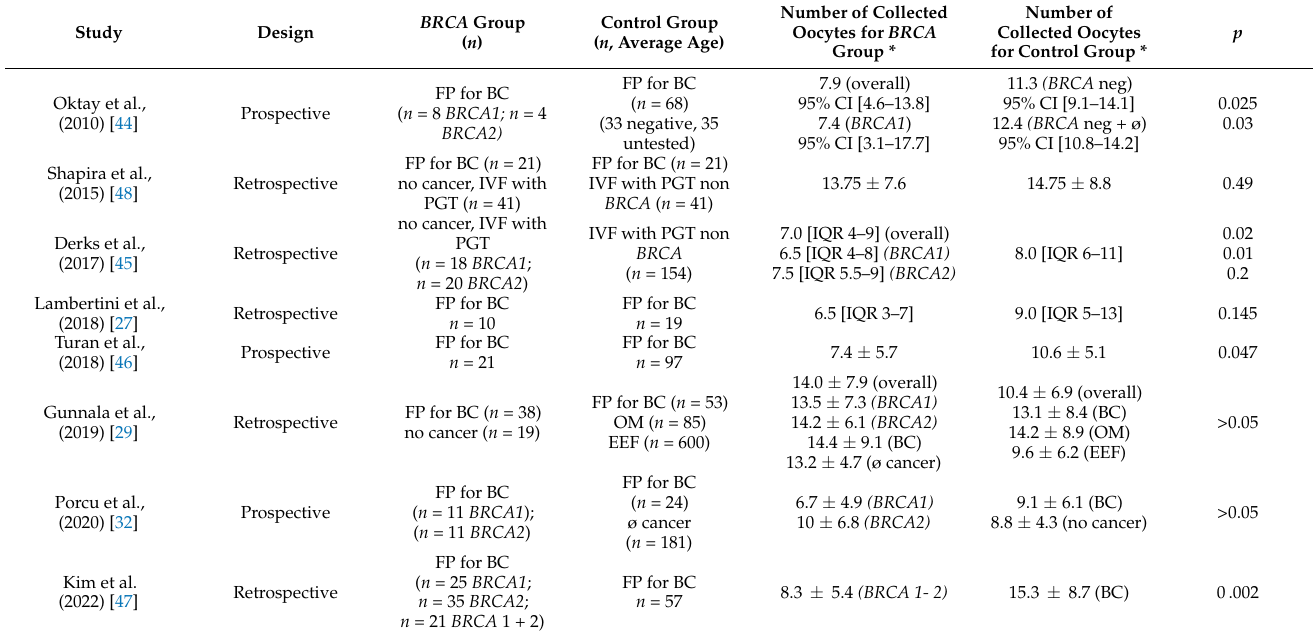
Table 2. Studies assessing response to ovarian stimulation in case of BRCA